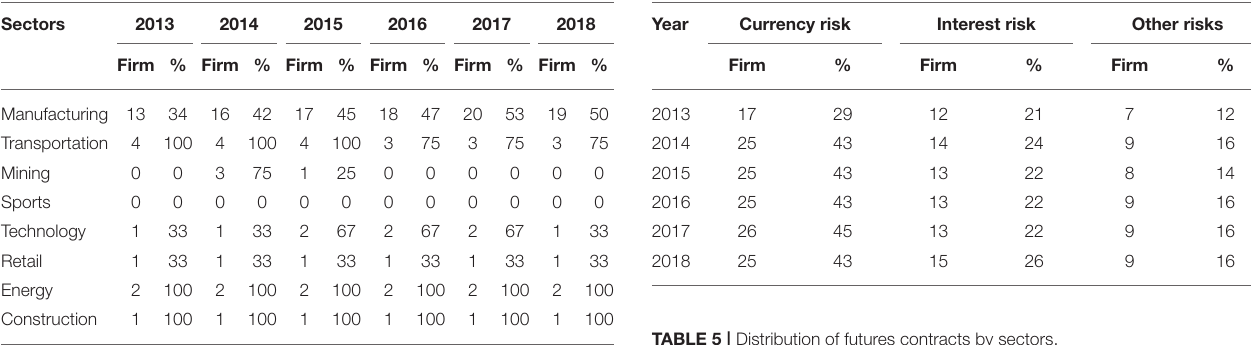
TABLE 5 | Distribution of futures contracts by